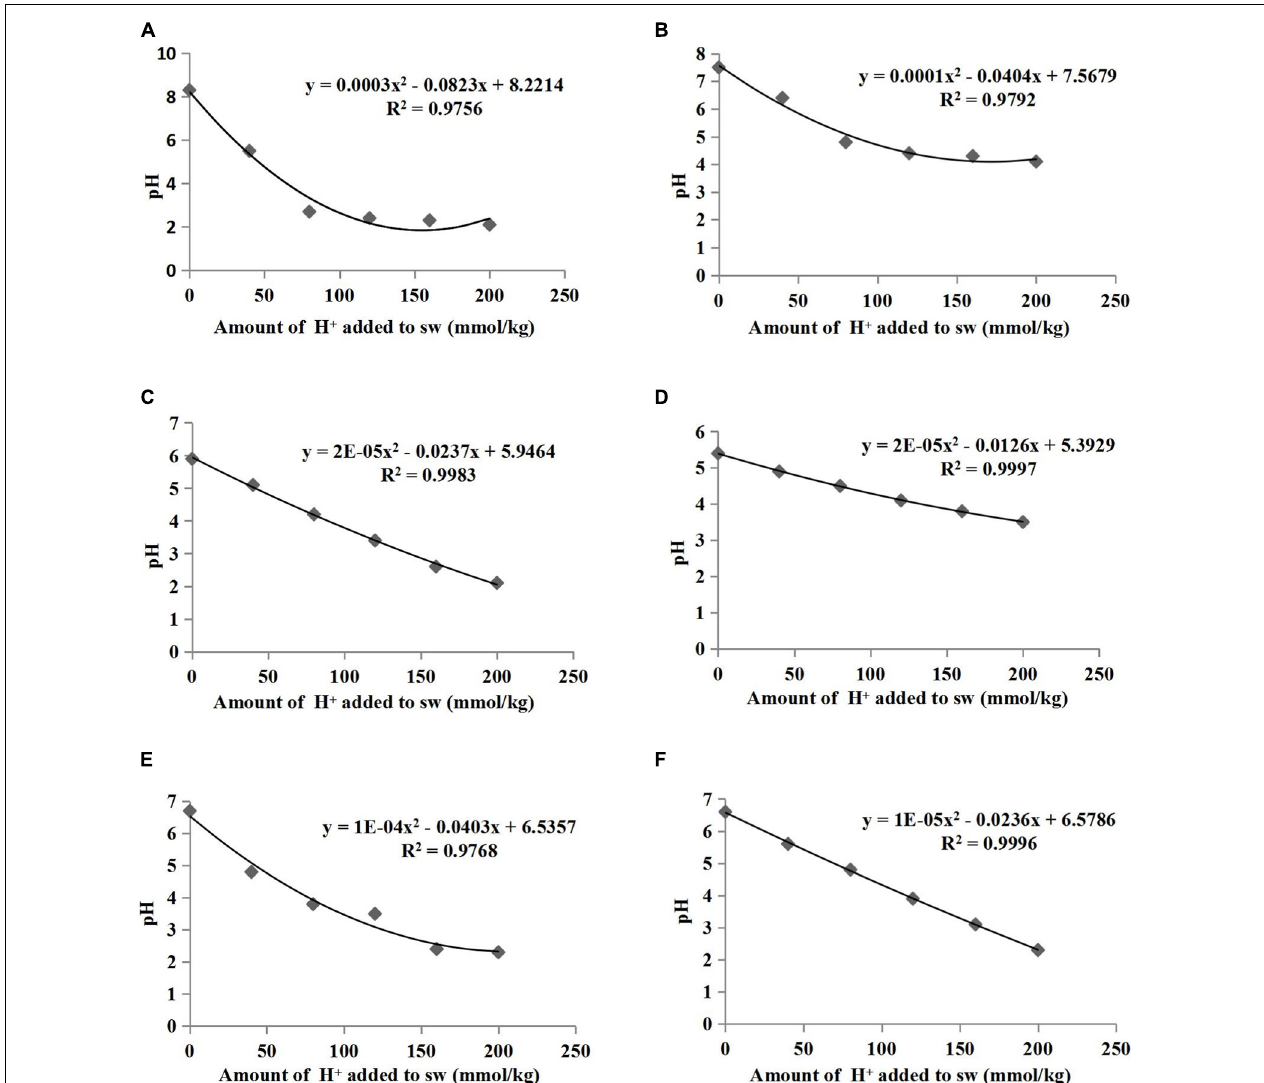
FIGURE 1 | Relationships between the amount of acid added to substrate weight (sw) and the pH of sand (A) , sand+1% HA (B) , cocopeat (C) , cocopeat+1% HA (D) , 1:1 sand:cocopeat (E) , and 1:1 sand:cocopeat +1% HA (F) suspensions.